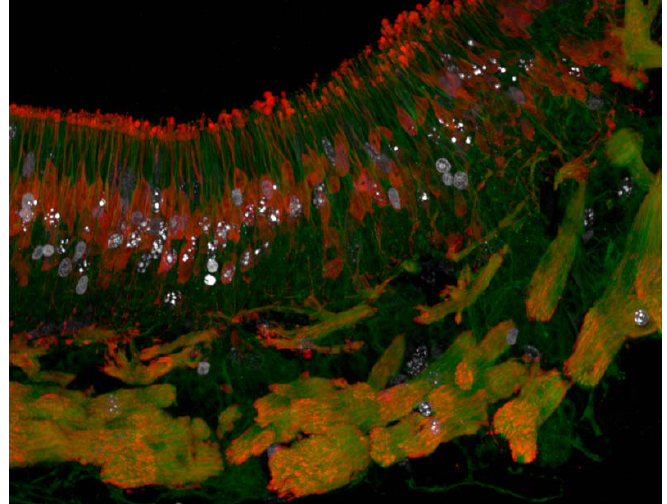
Figure 1. Mature (red) and immature (green) sensory neurons colocalise with EdU (white) introduced into the proliferative cells of adult rodents, one week prior to tissue harvest. The majority of cells which underwent DNA synthesis during the period of EdU exposure have differentiated into immature and mature neurons following 7 days. The fluorescence conjugated azides are commercially available. The fluorescence molecules are widely used probes of small molecular size and bright emission, ranging from the ultraviolet to infrared wavelengths. They are readily multiplexed with other fluorescence techniques including immunofluorescence. Thus, these techniques are robustly applied to track cell genesis and adult stem